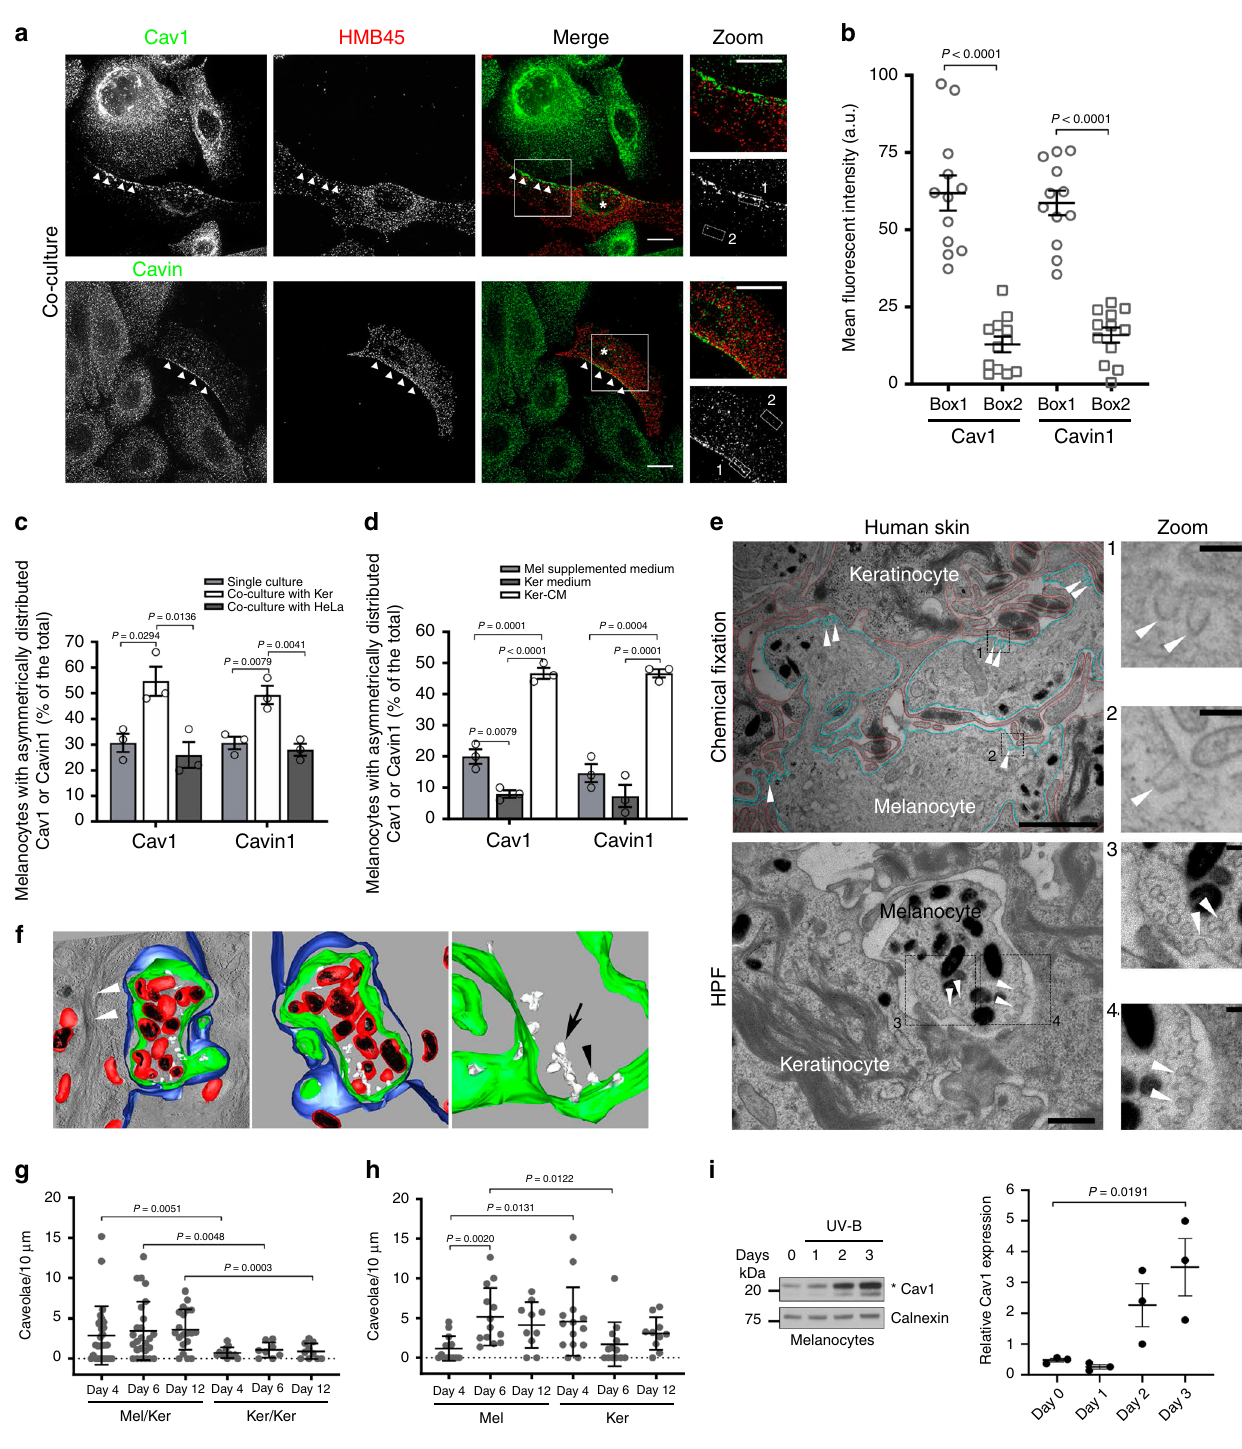
their native state 34 , processed for ultrathin (60 nm) sectioning and analyzed by 2D conventional transmission electron micro- scopy (TEM) (Fig. 1e and Supplementary Fig. 1d). The melanocyte – keratinocyte interface revealed numerous plasma membrane-associated cup-shaped invaginations, with a diameter between 43 and 102 nm and an average size of 63.9 nm, which lacked an electron-dense cytoplasmic coat (Fig. 1e and Supple- mentary Fig. 1d, arrowheads). Immunogold labeling on ultrathin cryosections of human skin samples revealed that these invagi- nations were positive for Cav1 in melanocytes (Supplementary